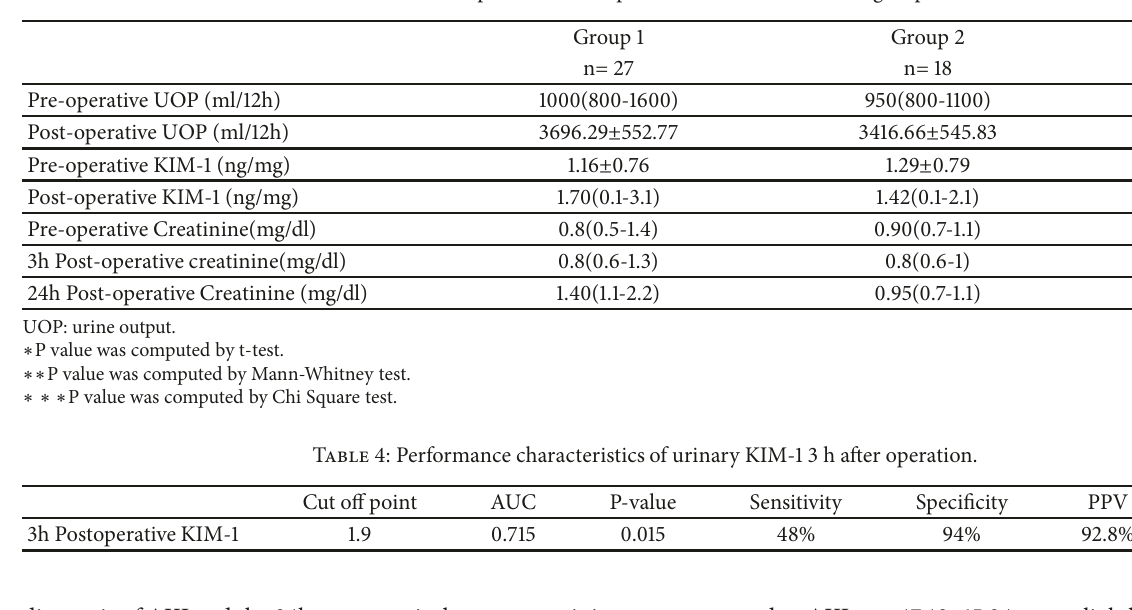
Table 3: Comparison of AKI parameters between the two groups.